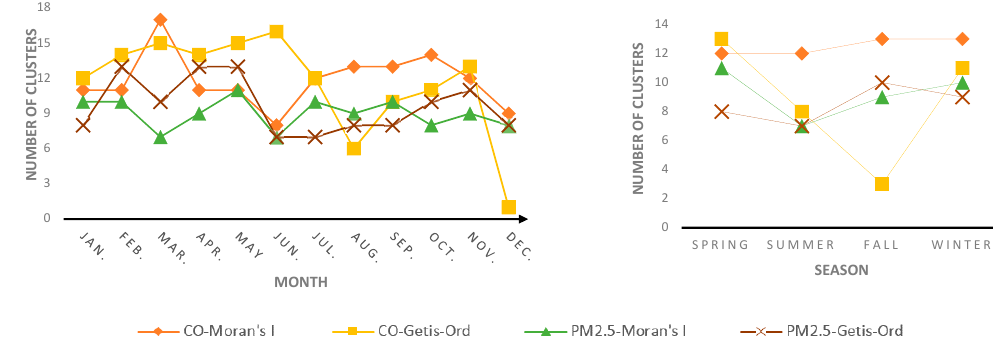
Figure 4. Monthly ( left ) and seasonal ( right ) number of carbon monoxide (CO) and fine particulate matter (PM 2.5 ) clusters identified by local Moran’s I and Getis-Ord G i .